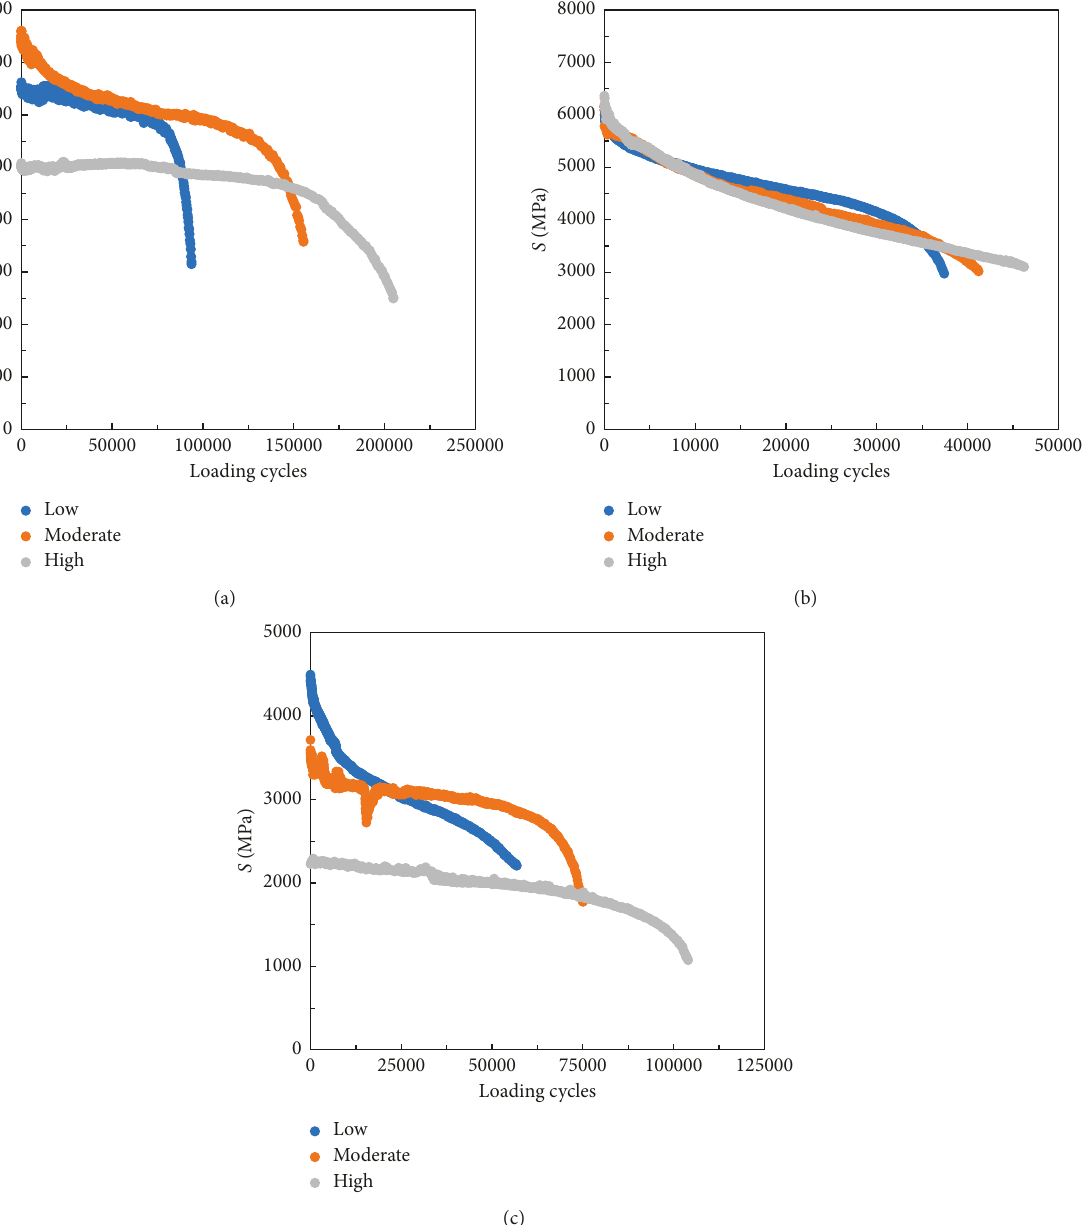
Figure 10: Influences of the asphalt content on the fatigue performance of asphalt mortar: (a) 5 ° C, 700 με ; (b) 5 ° C, 1000 με ; (c) 10 ° C, 1000 με